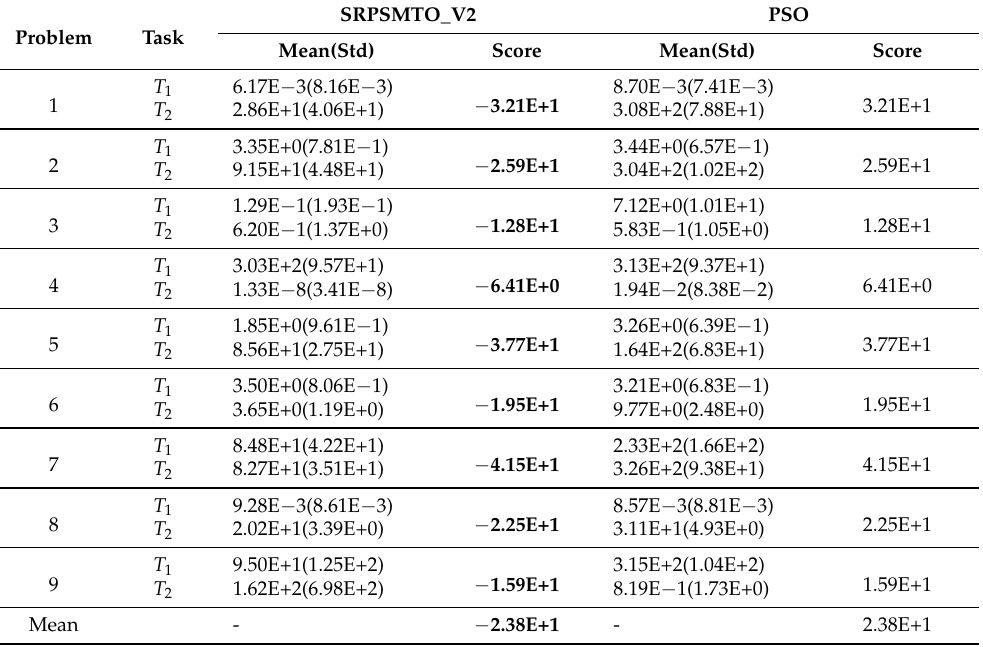
Table 4. Comparison of SRPSMTO (SRPSMTO_V2) and PSO in terms of the means, bracketed standard deviations and scores of the best achieved FEVs over 30 runs on test suite 1. The better results are shown in